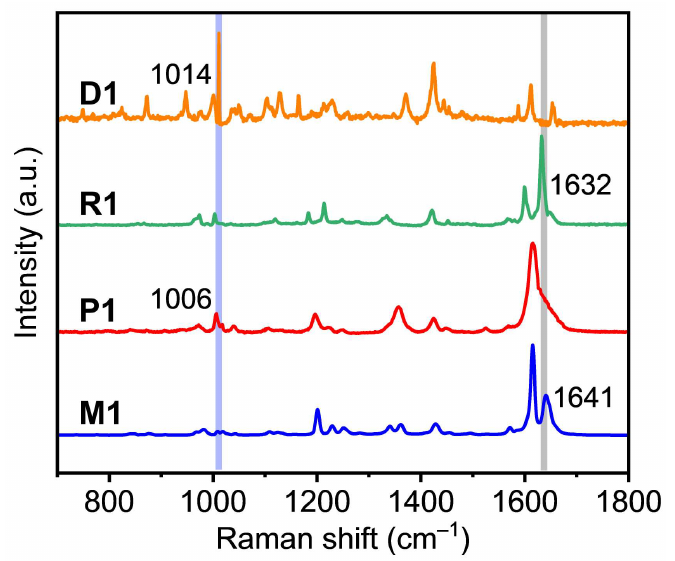
Figure 3. Raman spectra of D1 , R1 , P1, and M1 on SiO 2 /Si wafer. The blue and gray vertical lines correspond to the characteristic peak positions of cyclobutene and -C=C- bonds, respectively.